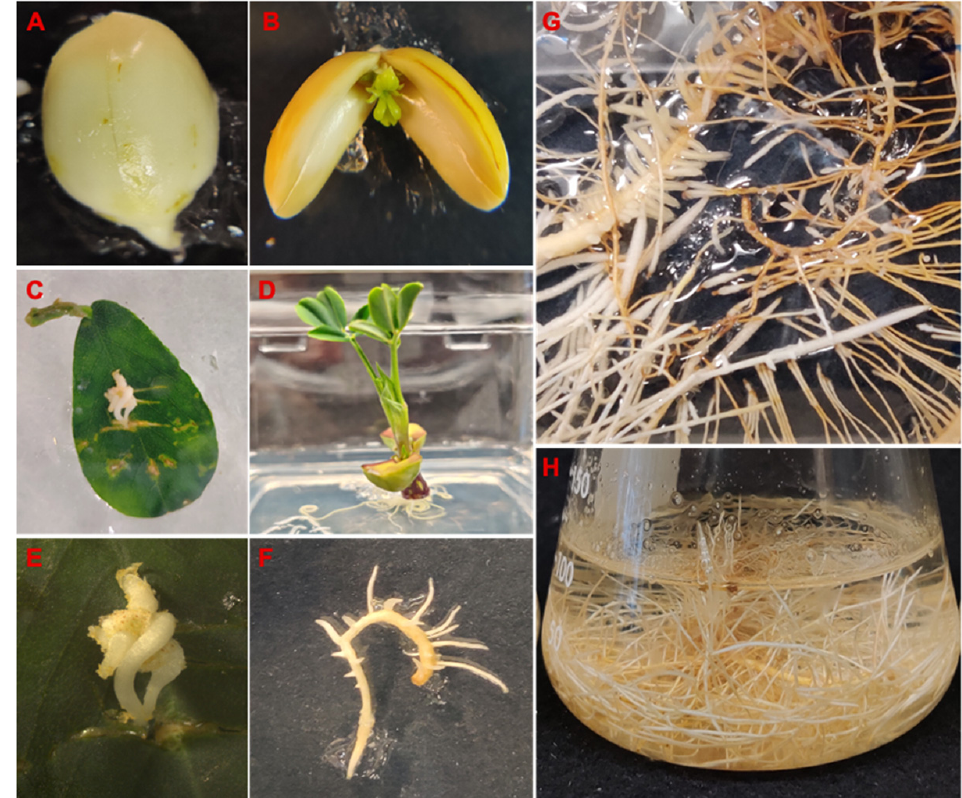
Figure 2 . Germination and establishment of hairy root cultures of peanut cv. Tifrunner. ( A ): Seed germination; ( B ): One-week-old seedling; ( D ): Three-week-old seedling; ( C , E ): Hairy root development from leaf infected with Agrobacterium rhizogenes ; ( F ): Branching of hairy roots after excision from the leaf; ( G ): Phenotype of hairy root line 1 on semi-solid medium; ( H ): Phenotype hairy root line 1 in liquid medium after 15 days in culture.